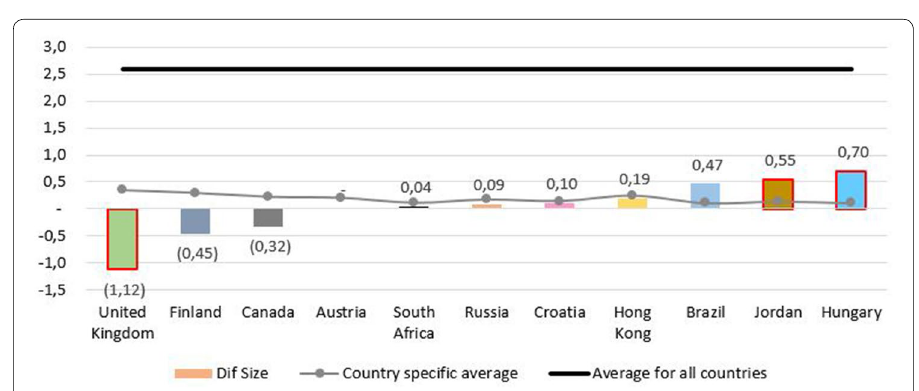
Fig. 8 DIF size: question 6—compound